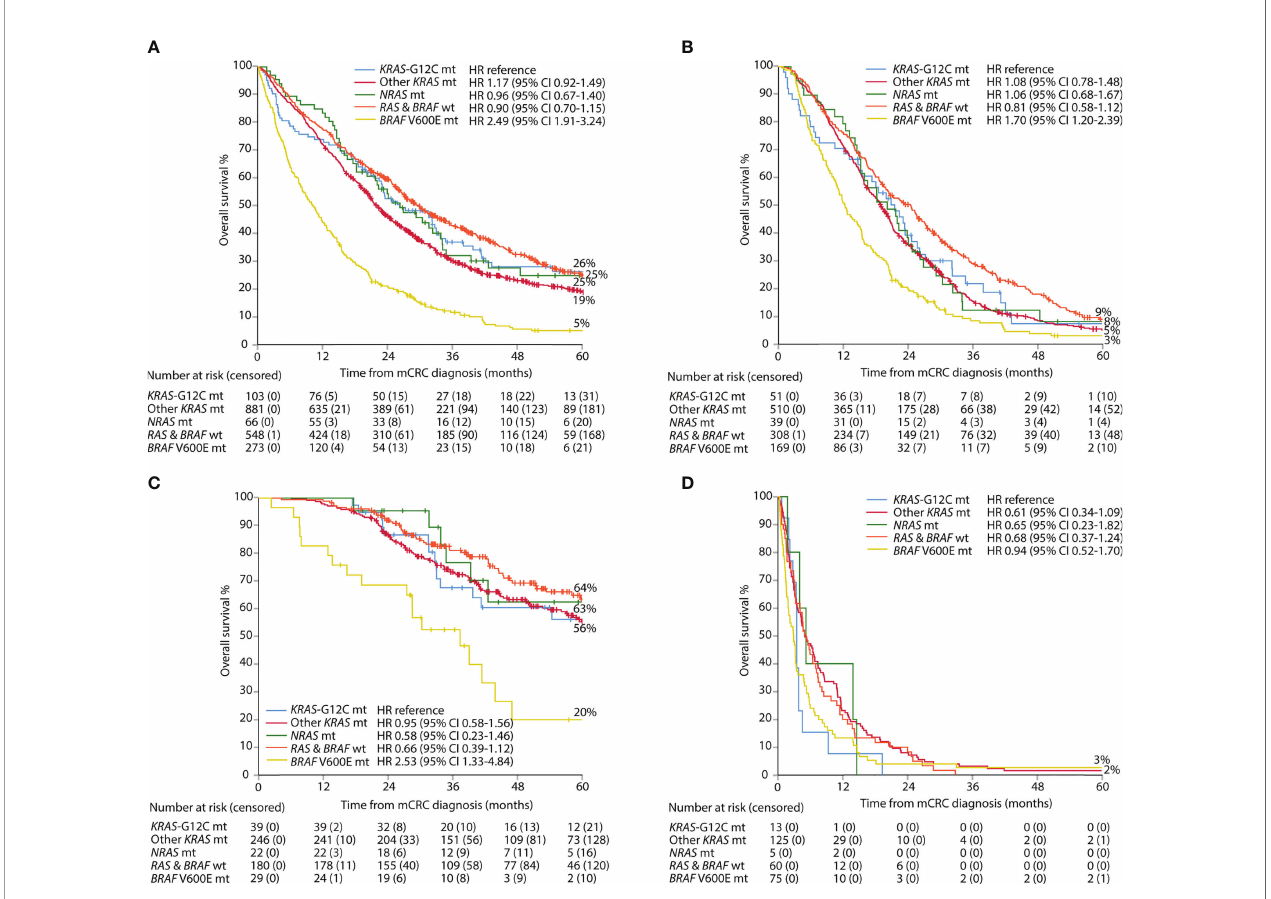
FIGURE 2 | Overall survival per group of mutation: all patients (A) , systemic therapy only (B) , metastasectomy and/or local ablative therapy (C) , and best supportive care (D)